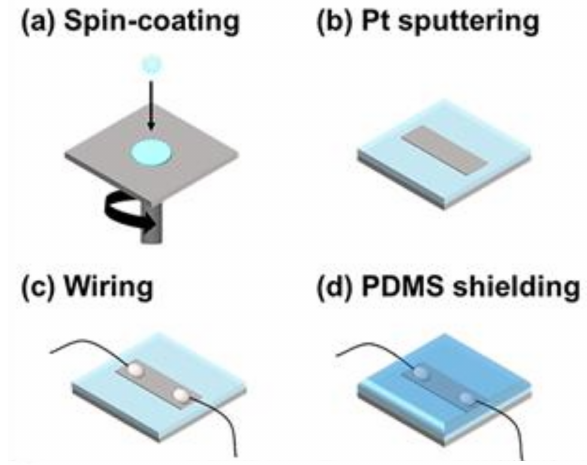
Figure 1. Fabrication of the poly(dimethylsiloxane) (PDMS)-shielded omni-purpose stretchable strain (OPSS) sensor. ( a ) Spin-coating of the polyurethane (PU) solution; ( b ) platinum (Pt) sputtering over a pattered film mask; ( c ) wiring process for measuring change in the resistance of the sensor; ( d ) shielding of the OPSS sensor with